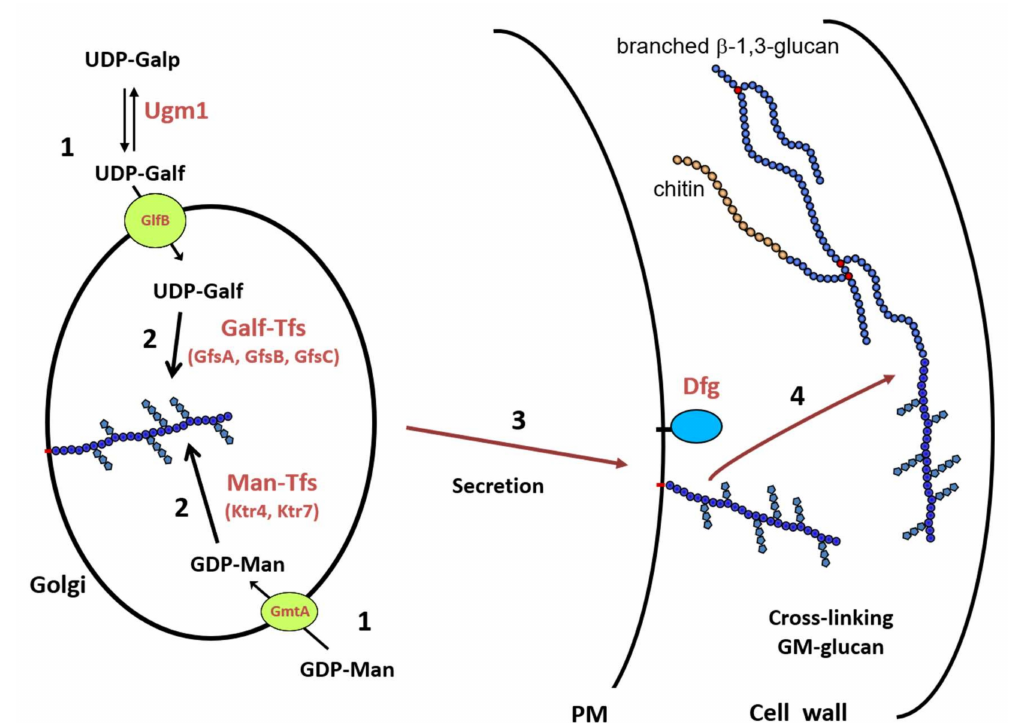
Figure 3. Biosynthetic scheme of the cell wall GM biosynthesis in A. fumigatus . ( 1 ) Synthesis of nucleotide-sugars in the cytosol and their transport into the lumen of the Golgi; ( 2 ) Polymerization of the GM by glycosyltransferases; ( 3 ) Intracellular tra ffi cking of the lipo-GM to the plasma membrane; ( 4 ) Cross-linking of the GM onto cell wall β -1,3-glucan. Abbreviations: UDP-Galp: UDP-galactoyranose; UDP-Galf: UDP-galactofuranose; GDP-Man: GDP-mannose; Ugm1: UDP-galactose mutase; GmtA: GDP-Man transporter; GlfB: UDP-Galf transporter; GfsA,B,C: β -galactofuranosyltransferases; Ktr4,7: α